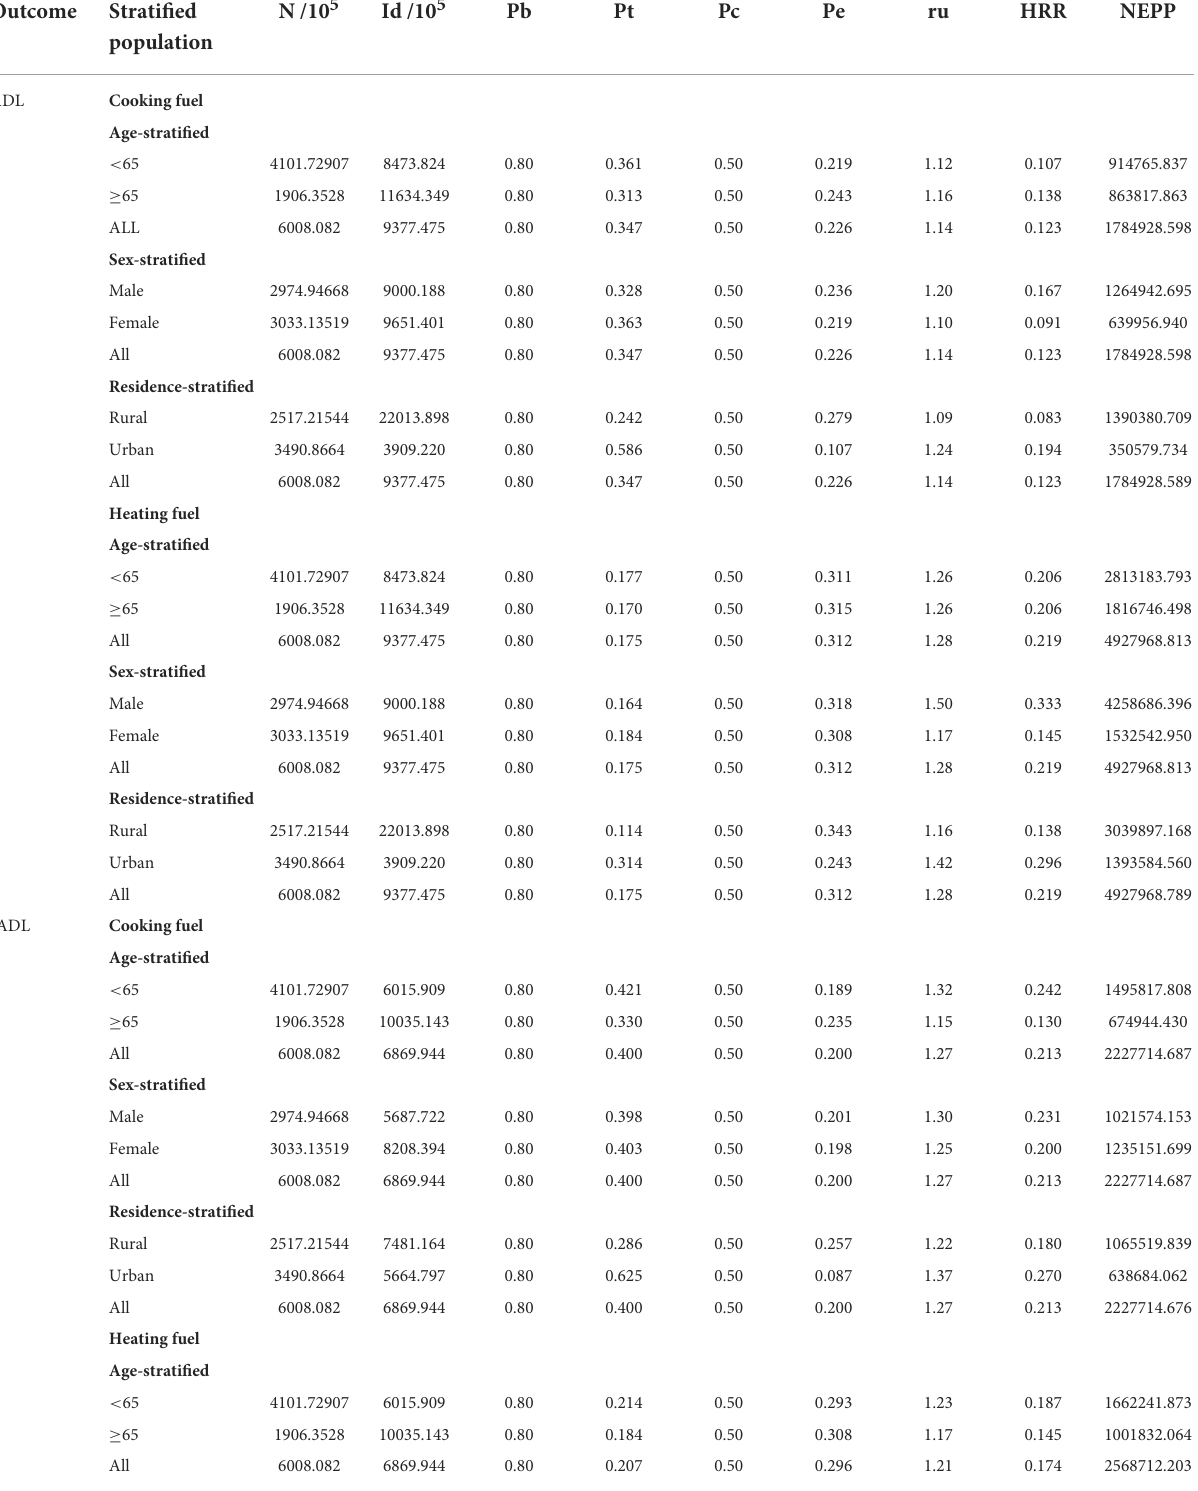
TABLE 3 Number of cases of ADL or IADL that could be prevented when prevalence levels of “clean fuel usage for up to 80%” in a Chinese